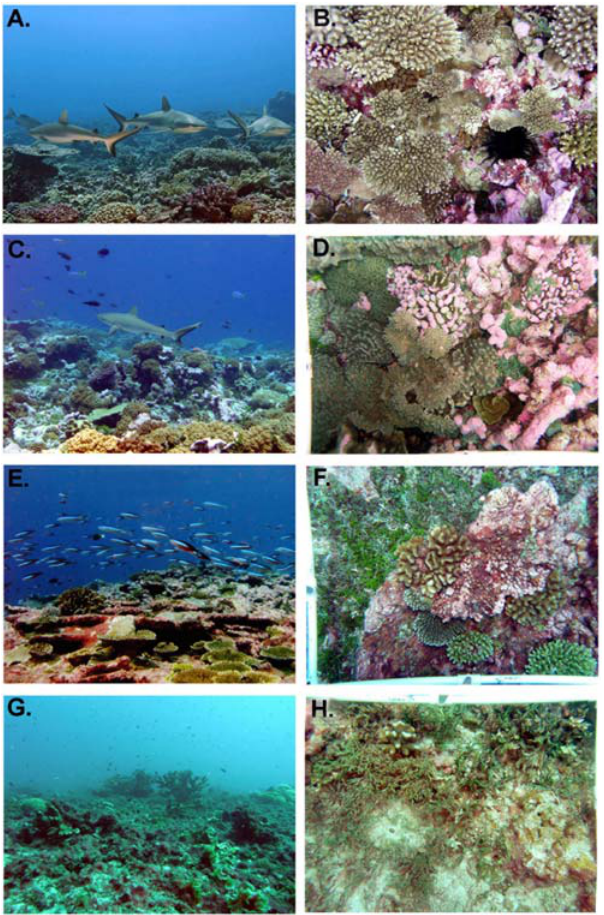
Figure 2. General aspect of fore reef habitats (left column) and representative 0.5-m2 photos of the bottom (right column) at Kingman (A–B), Palmyra (C–D), Tabuaeran (E–F), and Kiritimati (G–H), showing the degradation from a reef dominated by top